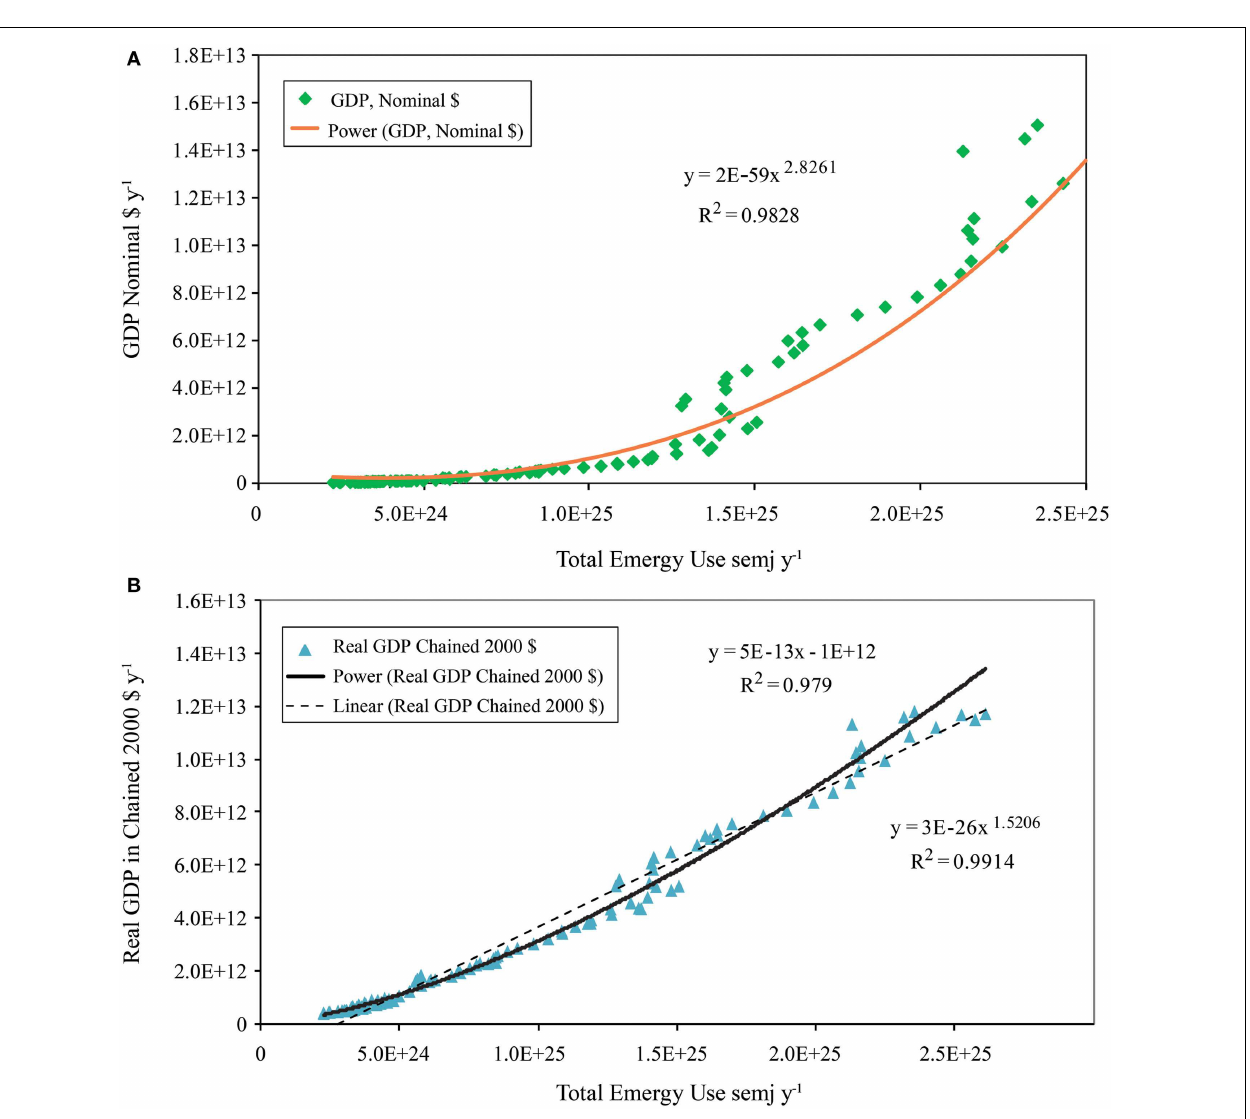
FIGURE 10 | GDP in nominal and in real dollars as a function of total emergy use is shown . (A) Nominal GDP as a function of total emergy use; (B) real GDP as a function of total emergy use.